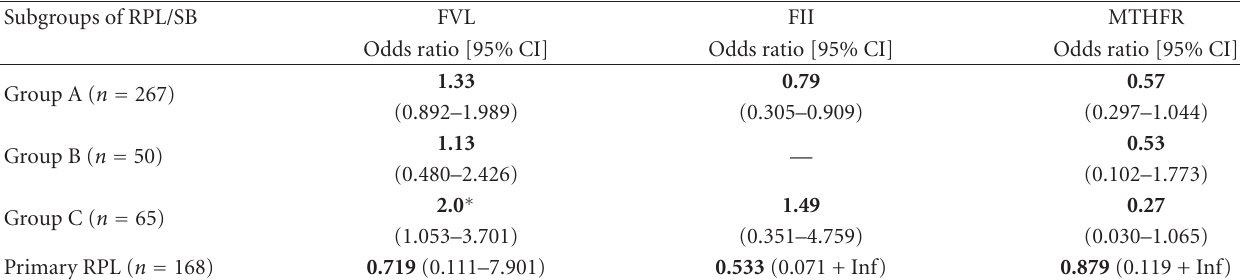
Table 3: FVL, FII; and MTHFR association with RPL Subgroups, SB; and primary RLP.